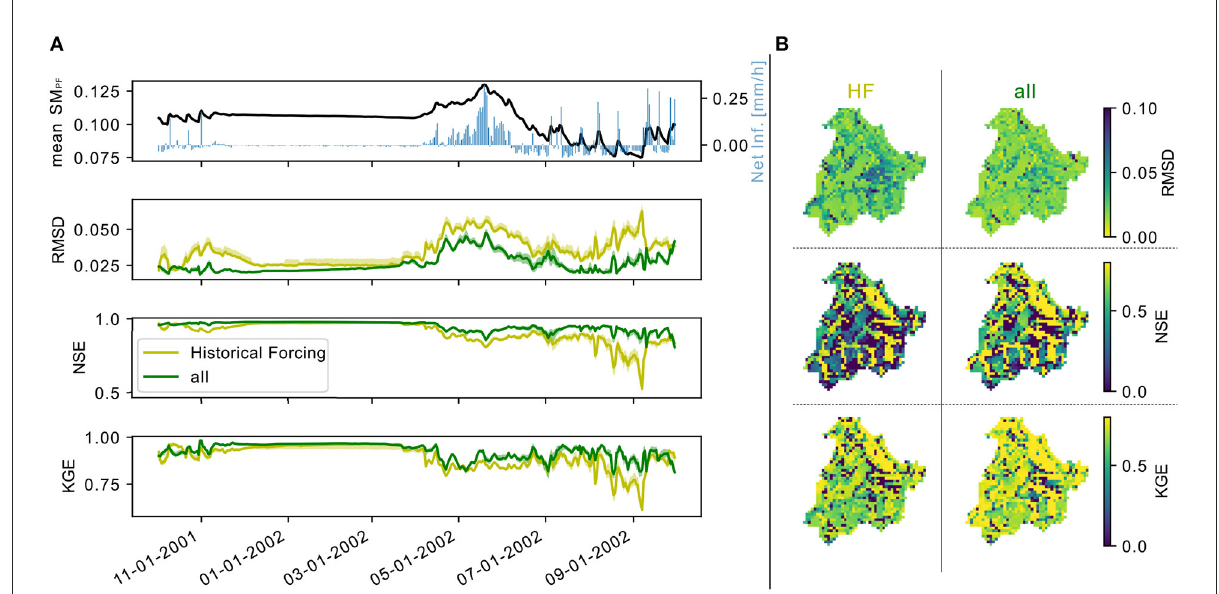
FIGURE8 In (A) , the timeseries of ParFlow-CLM (PF) domain average in time for the water year 2002 and the testing forcing scenario (mean SM PF ) and the simulated net infiltration (qflx_infl-qflx_tran_veg ParFlow-CLM variables). Below, the timeseries of Root Mean Square Difference, Nash-Sutcliff Efficiency, and Kling-Gupta Efficiency comparing the PF mean to that of the 3D Convolutional Neural Network (CNN) trained only on the historical forcing simulations ( Historical Forcing, HF ) or also on the additional forcing scenarios ( all ). The semi-transparent bands represent the 0.2-0.8 interquartile ranges among repetitions of the same ML configuration (i.e., different initialization). In (B) , the temporal statistics comparing the timeseries at each pixel of PF and the 3D CNN trained just on historical forcing simulations or also on those with additional forcing